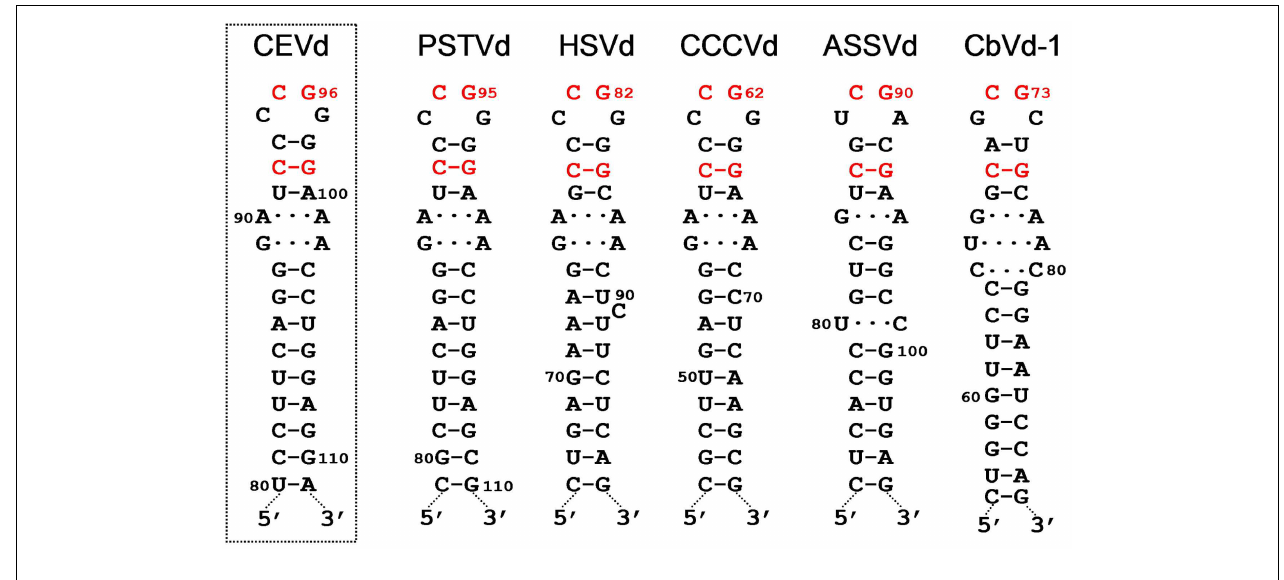
respectively. Notice that the variability preserves the overall structure of hairpin I, including the terminal palindromic tetraloop, the adjacent 3-bp stem, and the long stem. Left inset, hairpin I of the wild-type CEVd variant used to transform A. thaliana (notice two co-variations with respect to PSTVd at the basis of the long stem). Reproduced with permission from Gas et al.